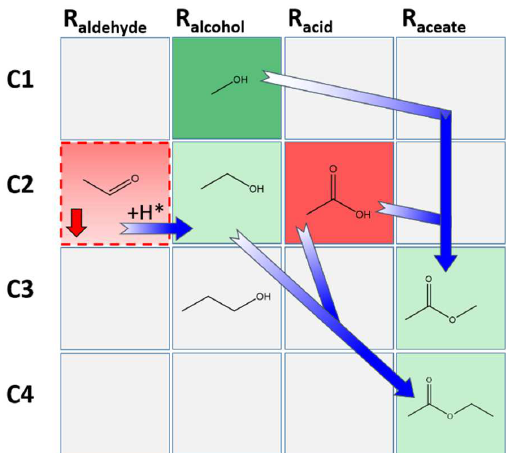
Figure 10. Changes in the formation rate of products following a decrease in R acetaldehyde . The color-coding rule follows that of Figure 9, where red and green denote a decrease and increase, respectively, and the darker shades reflect a stronger correlation.